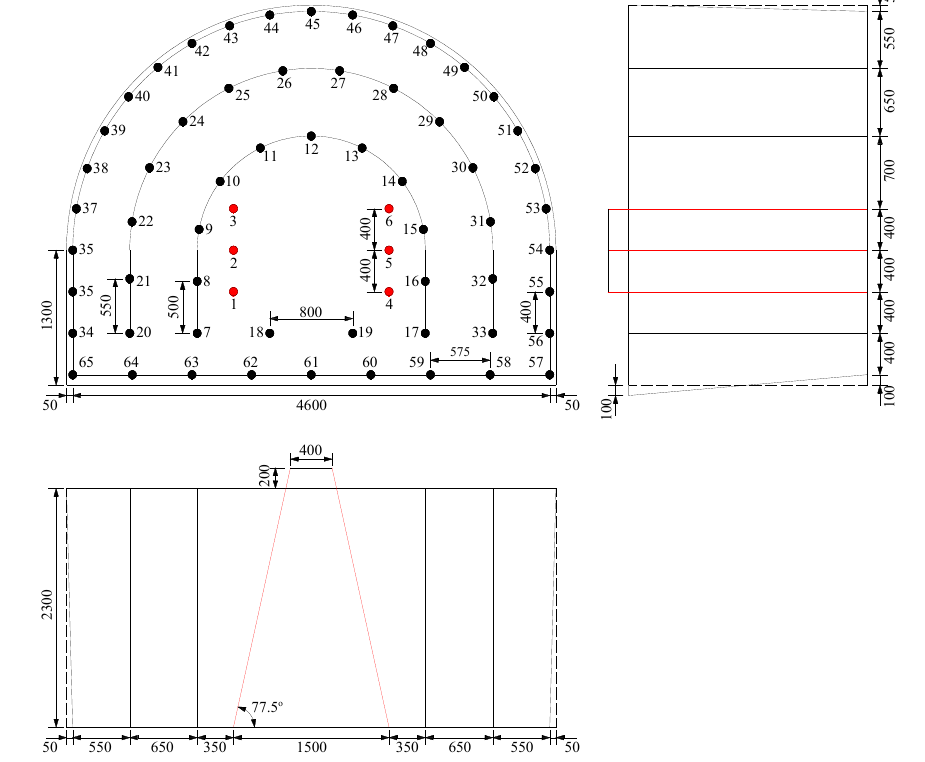
Figure 10. Blasting hole layout of the original scheme (unit: mm). Table 7. Statistical data of the final blasting results for the original